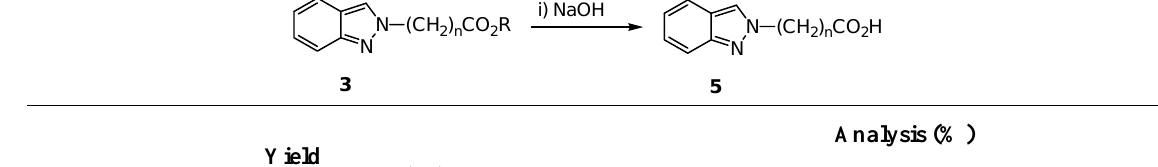
Table 3. Physical-chemical characteristics and elemental analyses of indazole carboxylic acids 5a-i. NN (CH 2 ) n CO 2